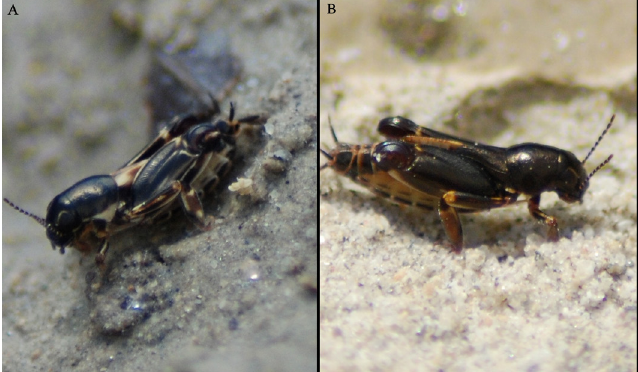
Figure 13. Xya species, Macedonia, Strimon river, 25 V 2016. A. X. variegata , B. X. pfaendleri.